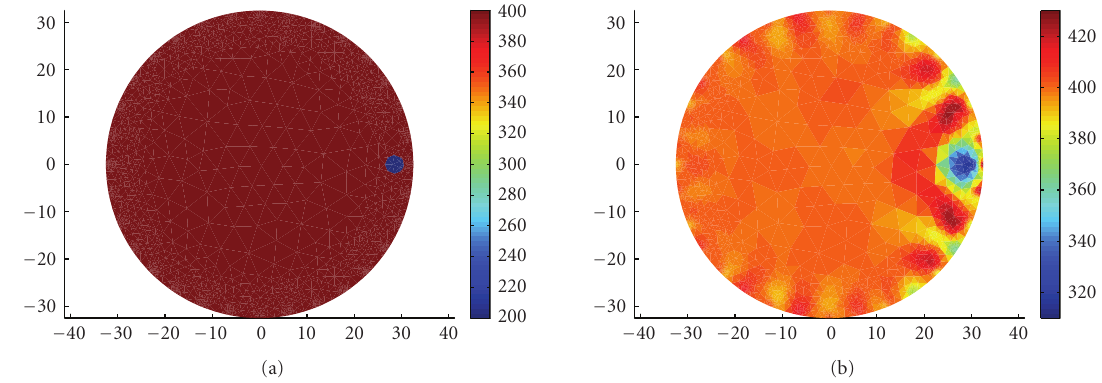
Figure 7: Example of an inhomogeneity near any of the electrodes and its reconstruction. (a) The simulated inhomogeneity. (b) The recon- structed map. The scale shows the impedance in Ω